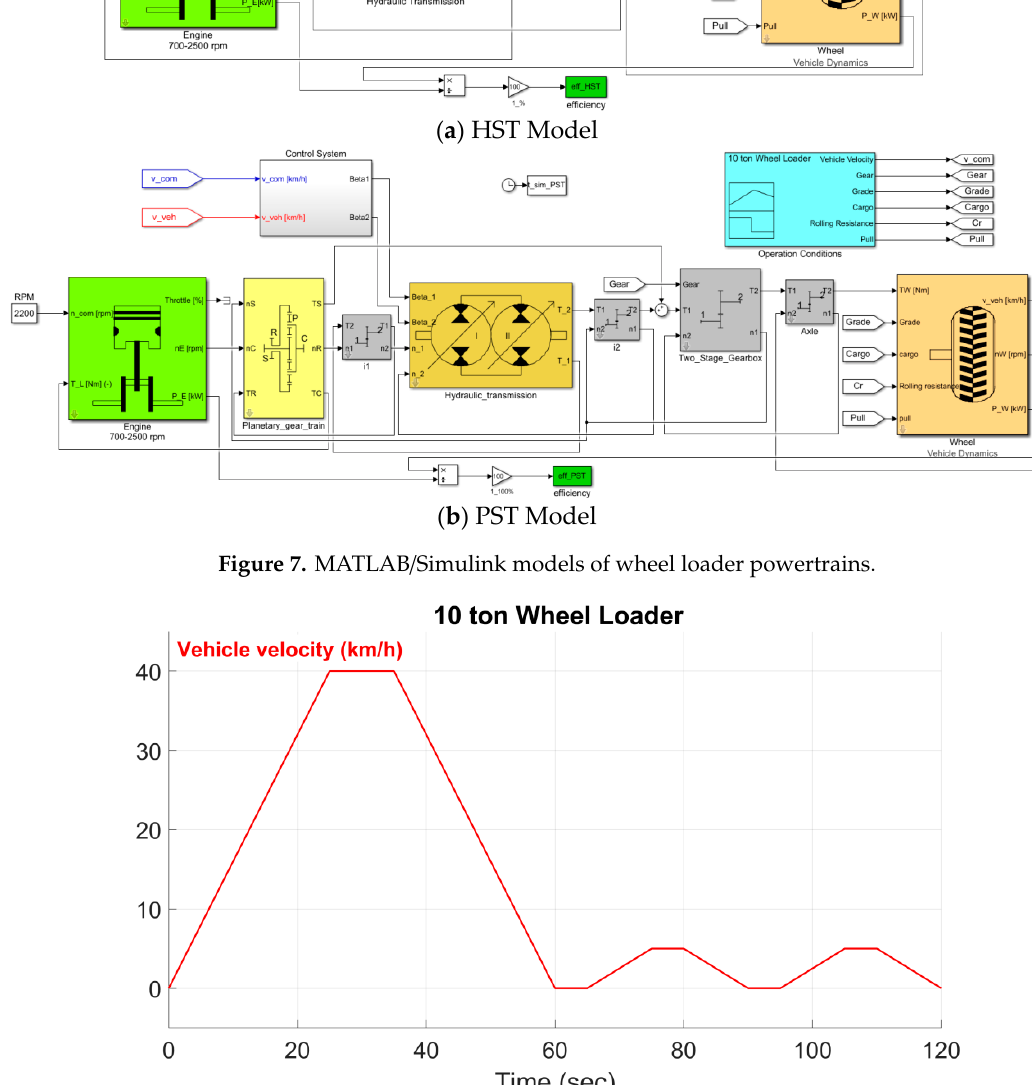
Figure 9. Wheel loader operation condition profiles of the predefined drive cycle. In this study, this simulation will analyze the following variables to evaluate and compare the performance of the wheel loader powertrains: •